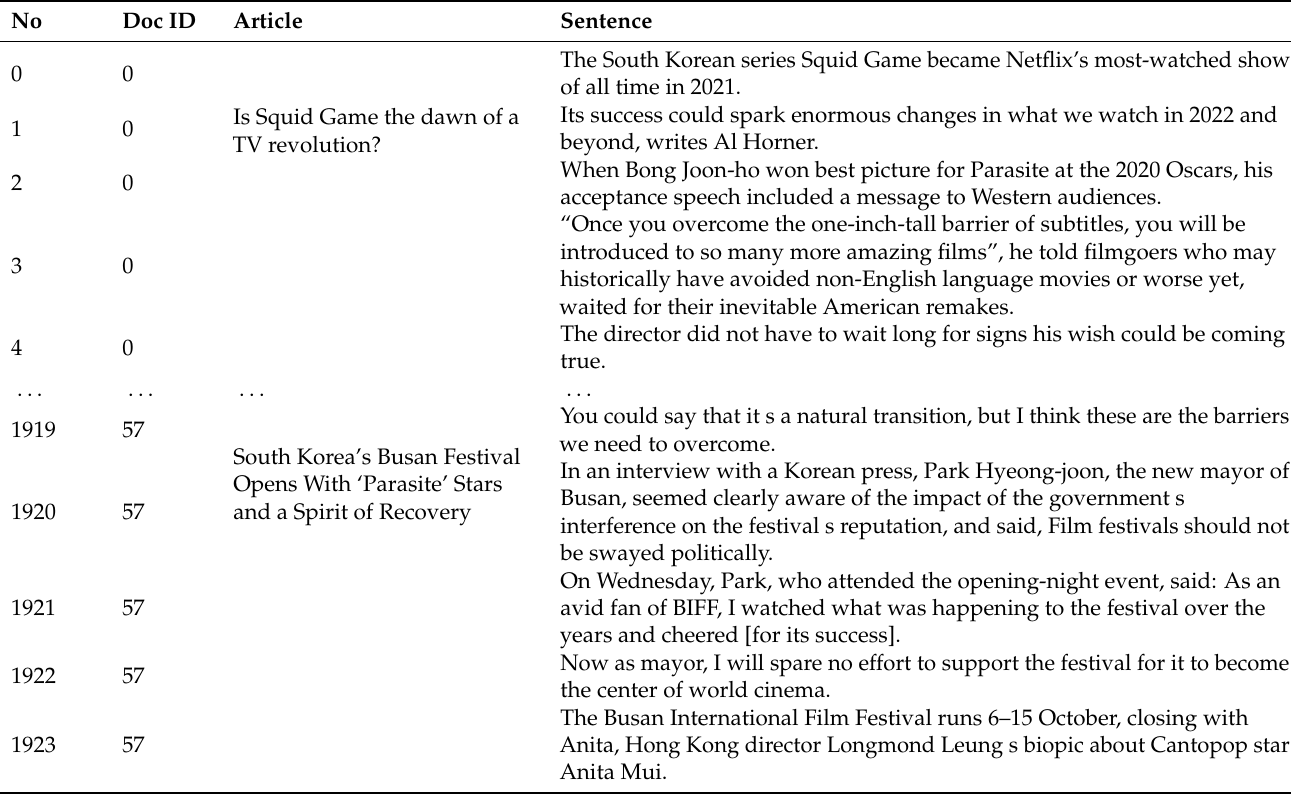
Table 3. Sentences obtained from news articles for the “Korea film